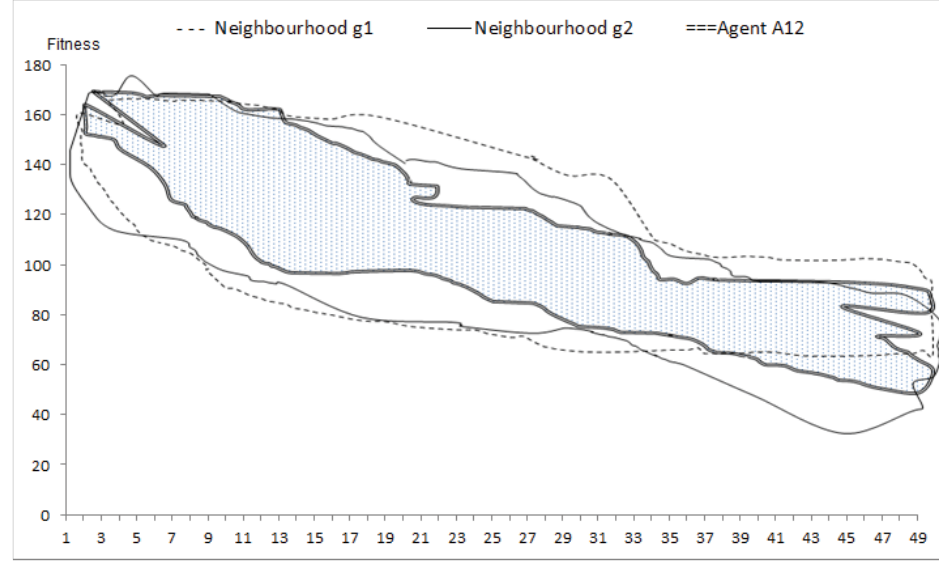
Figure 2: Fitness values within Neighborhoods g 1 and g 2 for all